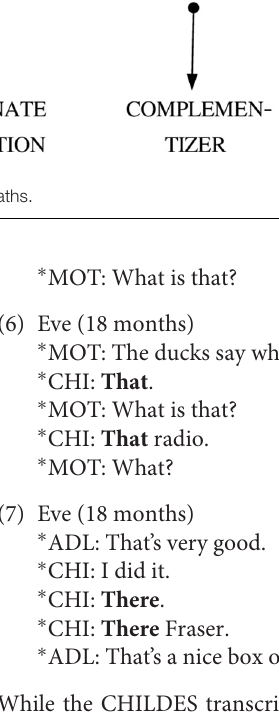
FIGURE 2 | The grammaticalization of demonstratives: Some frequent cross-linquistic paths.